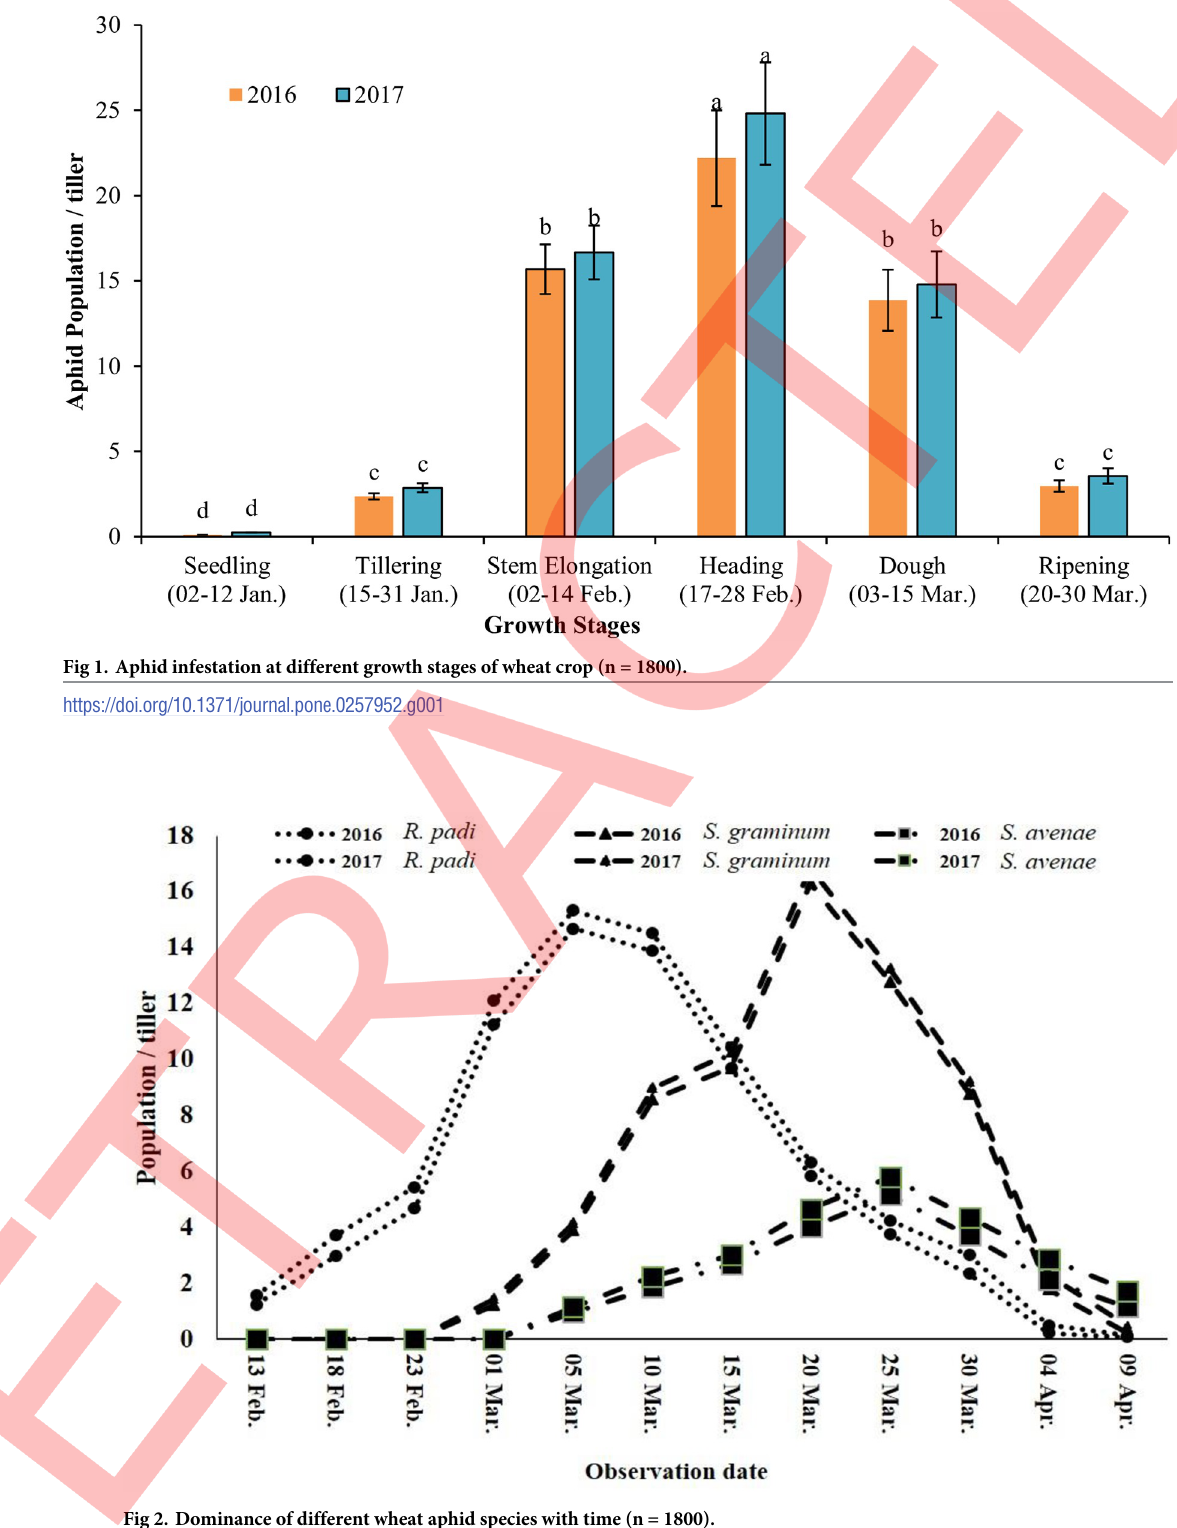
Fig 2. Dominance of different wheat aphid species with time (n = 1800).